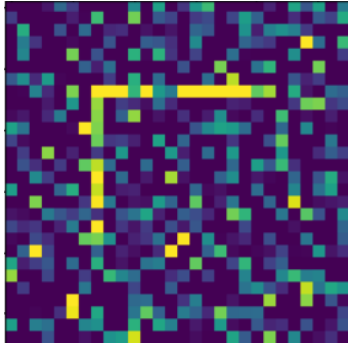
Figure 18. Level 4